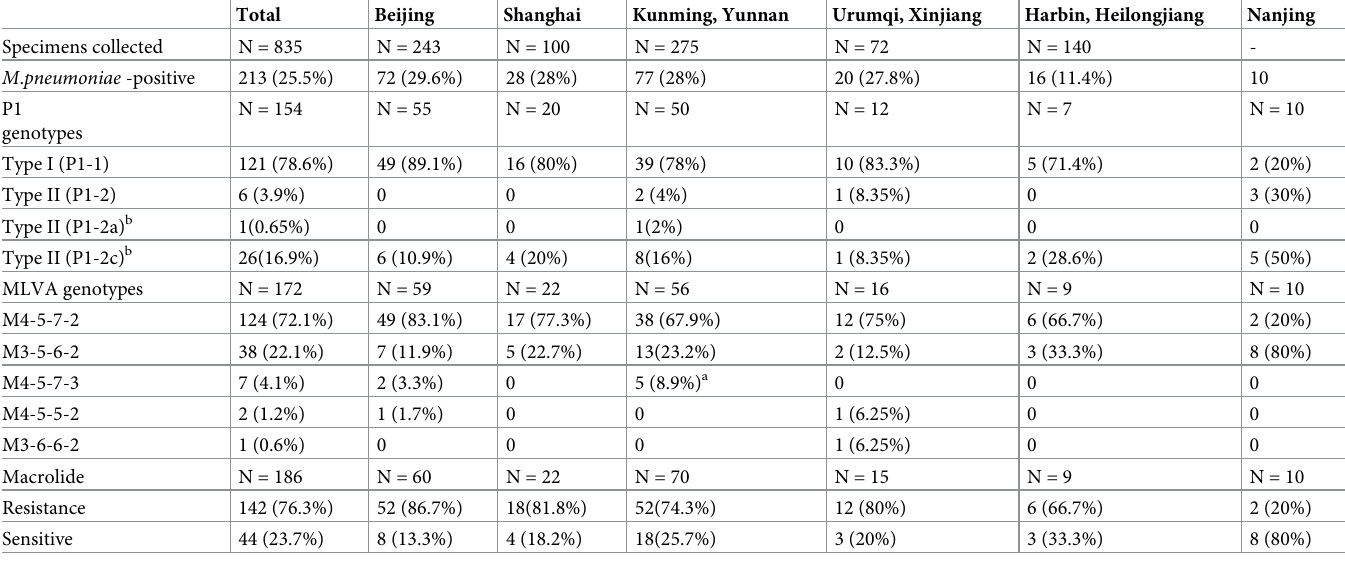
Table 1. Molecular characteristics of Mycoplasma pneumoniae from different